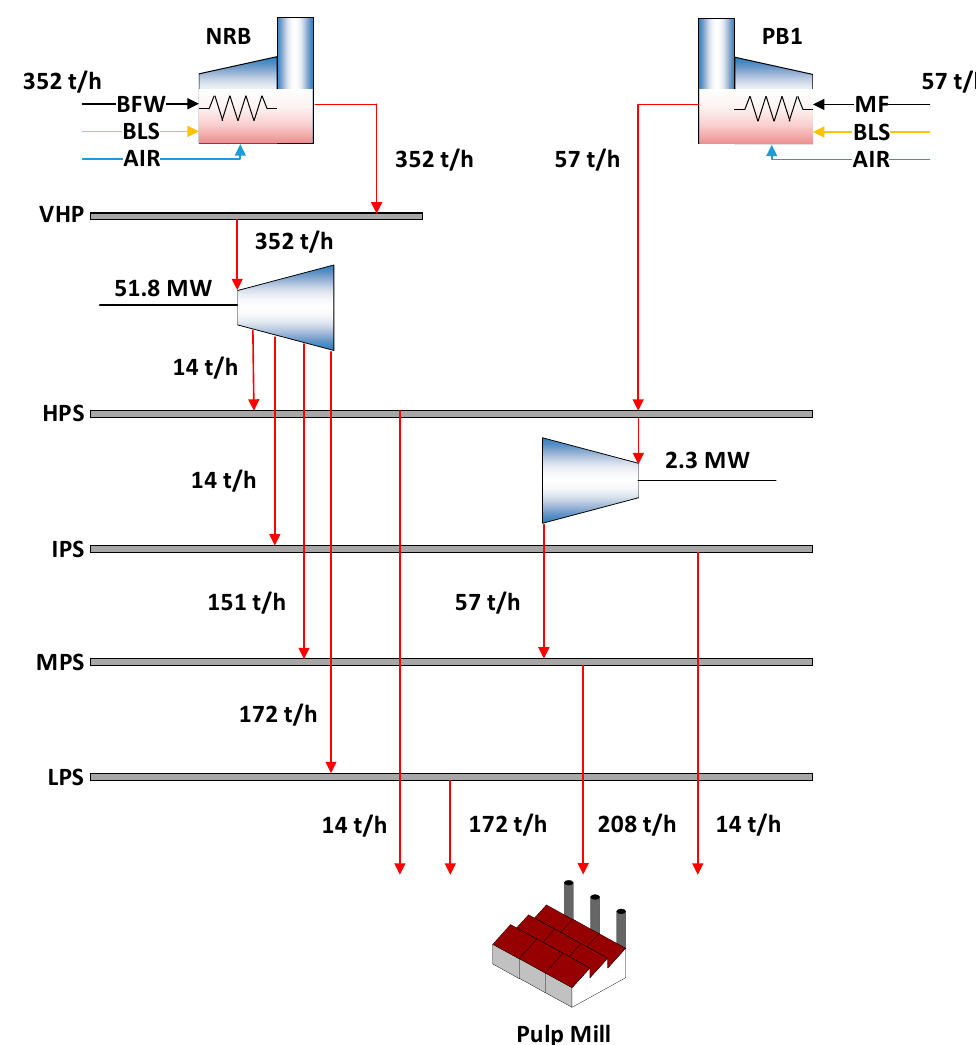
Figure 10. Utility system for kraft mill with a new recovery boiler.